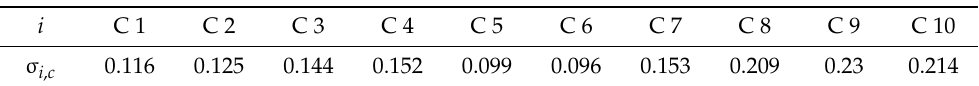
Figure 6. Flow distribution ratio of each layer. Table 2. Statistics of the standard deviation of the non-uniformity of each flow channel of each heat exchanger plate layer.